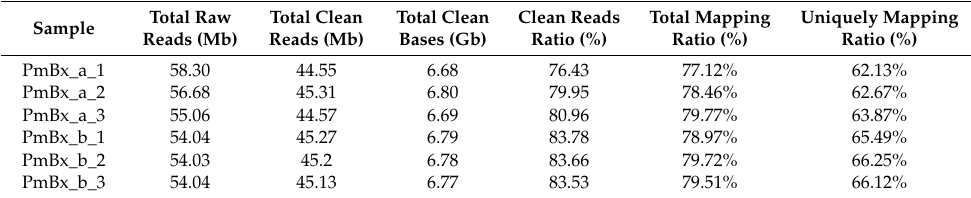
Table 2. Statistical data for RNA